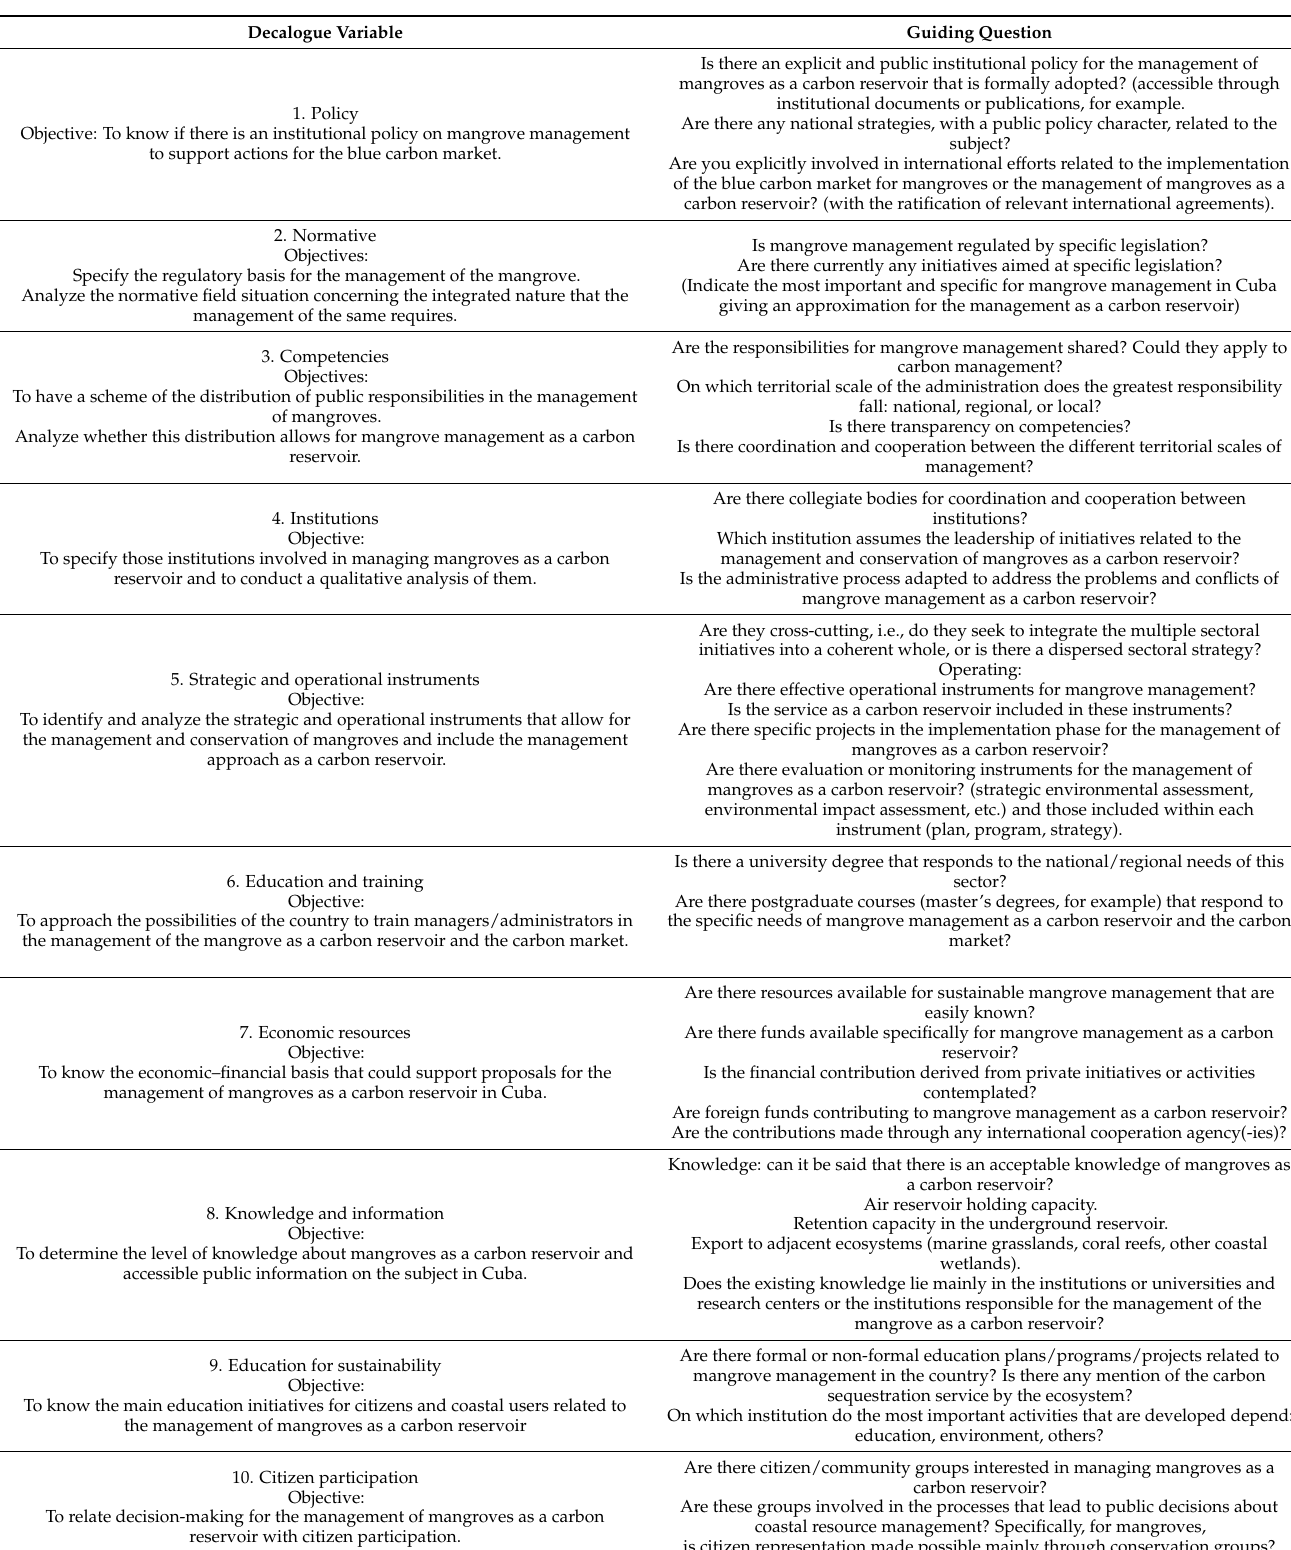
Table 1. Variables and guiding questions of the